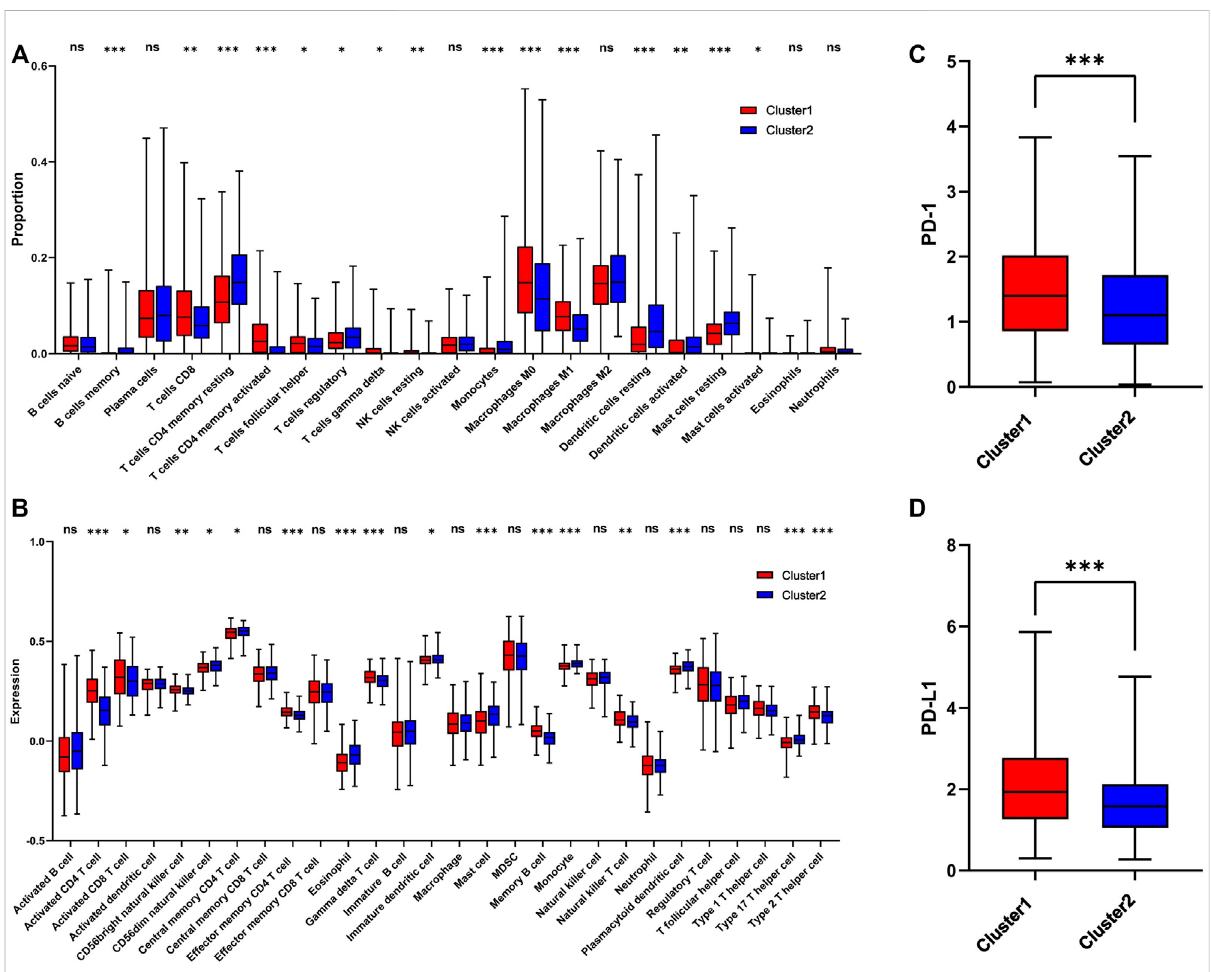
FIGURE 5 Immune pro fi le alterations between cluster 1 and cluster 2. (A) The difference of 22 immune cell types between cluster 1 and cluster 2; (B) The difference of 28 immune cell types between cluster 1 and cluster 2; (C) The difference of PD-1 expression level between the cluster 1 and cluster 2; (D) The difference ofPD-L1 expression level between cluster 1 and cluster 2. *means p < 0.05; ** means p < 0.01; *** means p < 0.001; ns means no signi fi cant